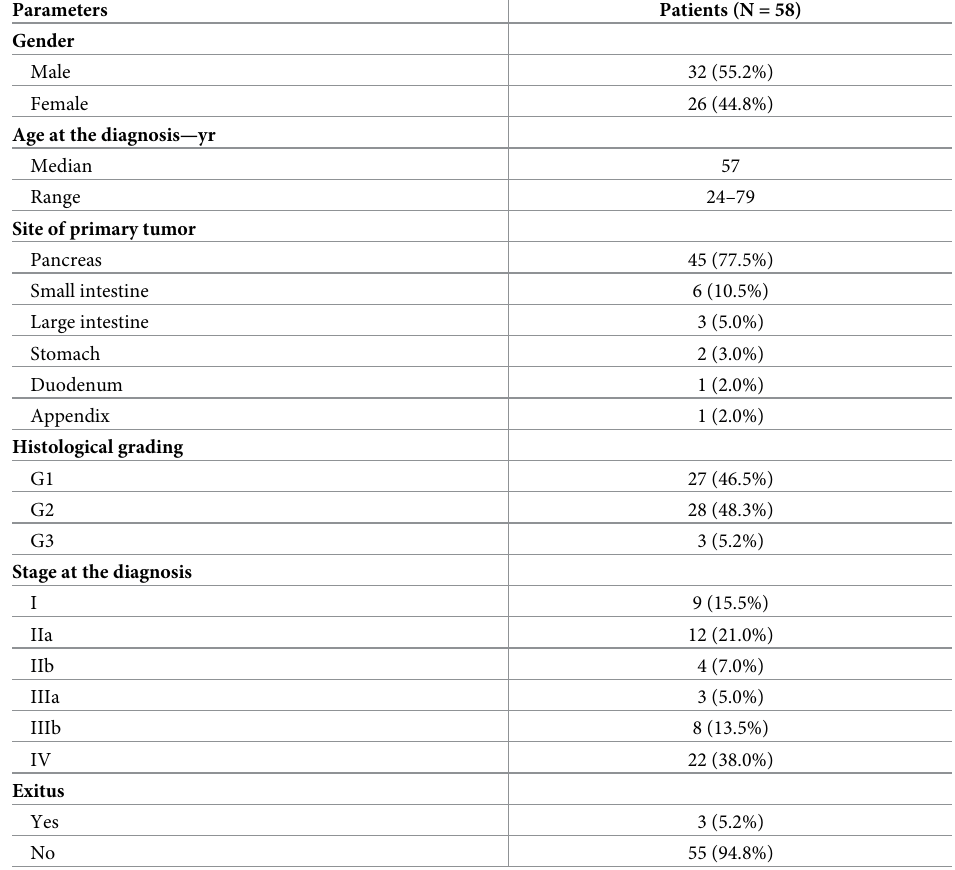
Table 1. Patients’